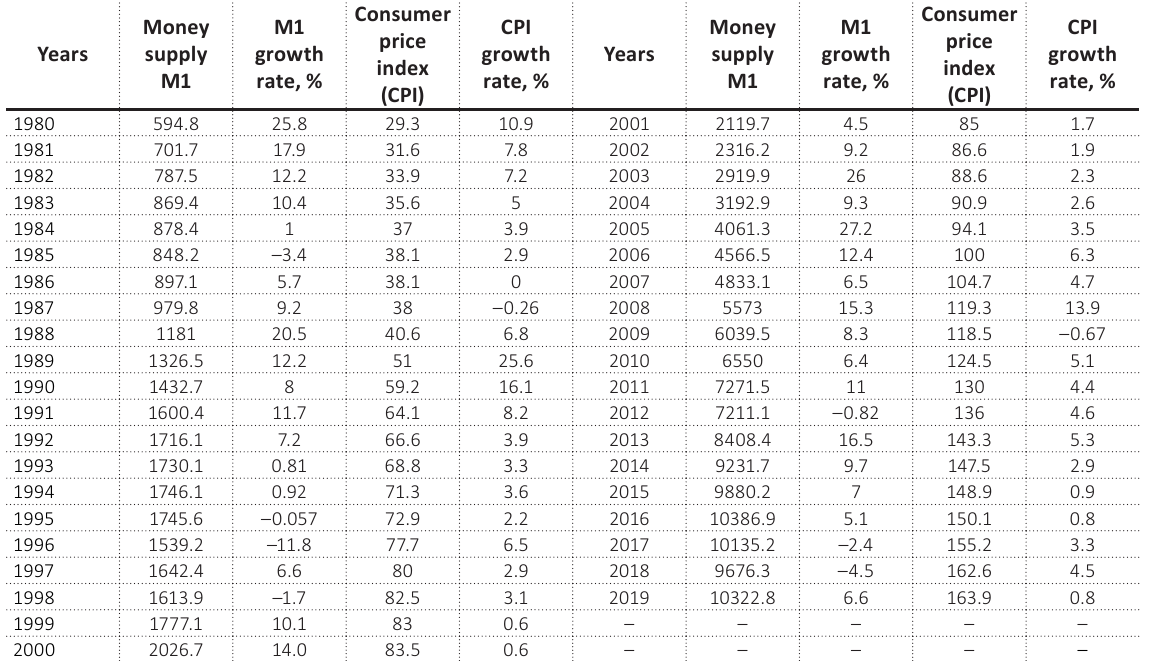
Table 1. Money supply M1 and consumer price index (CPI) (1980–2019) in Jordan, million JD